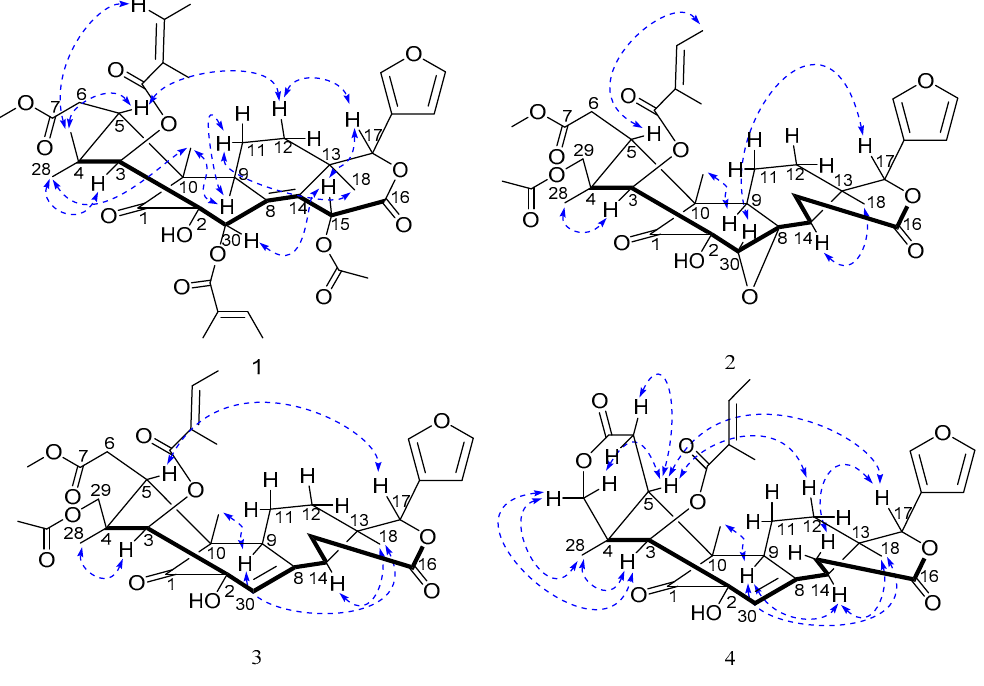
Figure 3 . Key ROESY correlations of 1 – 4 . Figure 3. Key ROESY correlations of 1 – 4